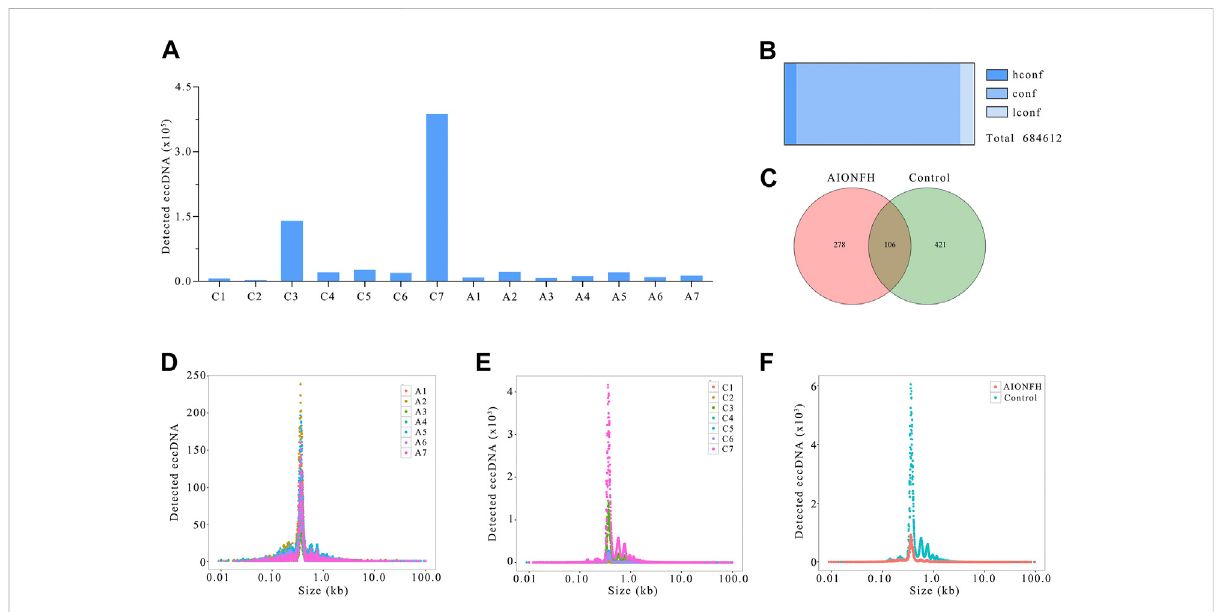
FIGURE 1 EccDNAs number, sizes distribution of AIONFH group and control group. (A) . The total amount of eccDNAs detected in each sample. (B) . Con fi dence of identi fi ed eccDNAs. (C) . Venn diagram showed the consist eccDNAs detected in AIONFH and control samples. (D – F) . The length distribution of eccDNAs ( < 100 kb) in each